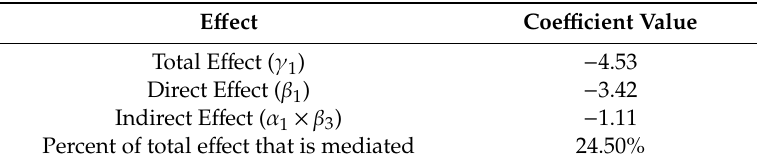
Table 5. Identification of mediation e ff ects.